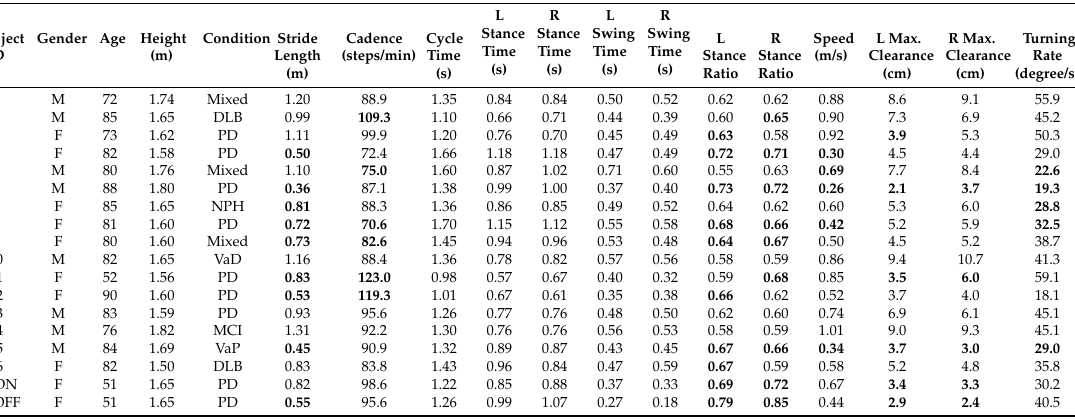
Table 4. Neurological disorder subjects and extracted gait metrics. DLB, dementia with Lewy bodies; NPH, normal pressure hydrocephalus; VaD, vascular dementia; VaP, vascular Parkinsonism; MCI, mild cognitive